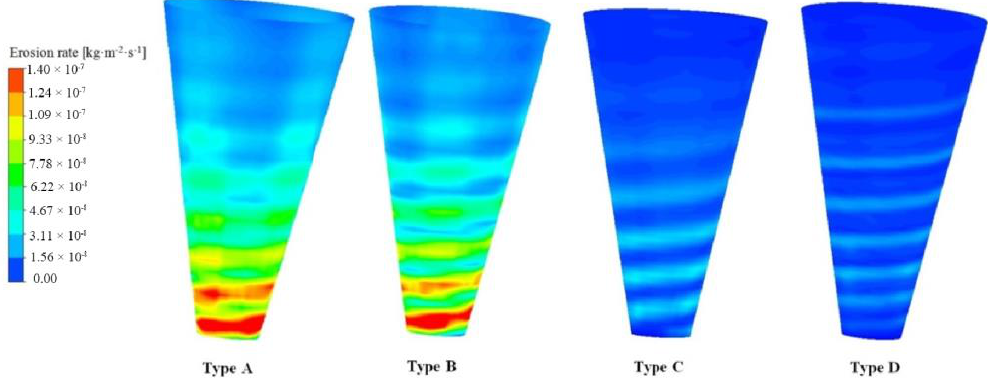
Figure 20. Cone erosion contour with different vortex finders.